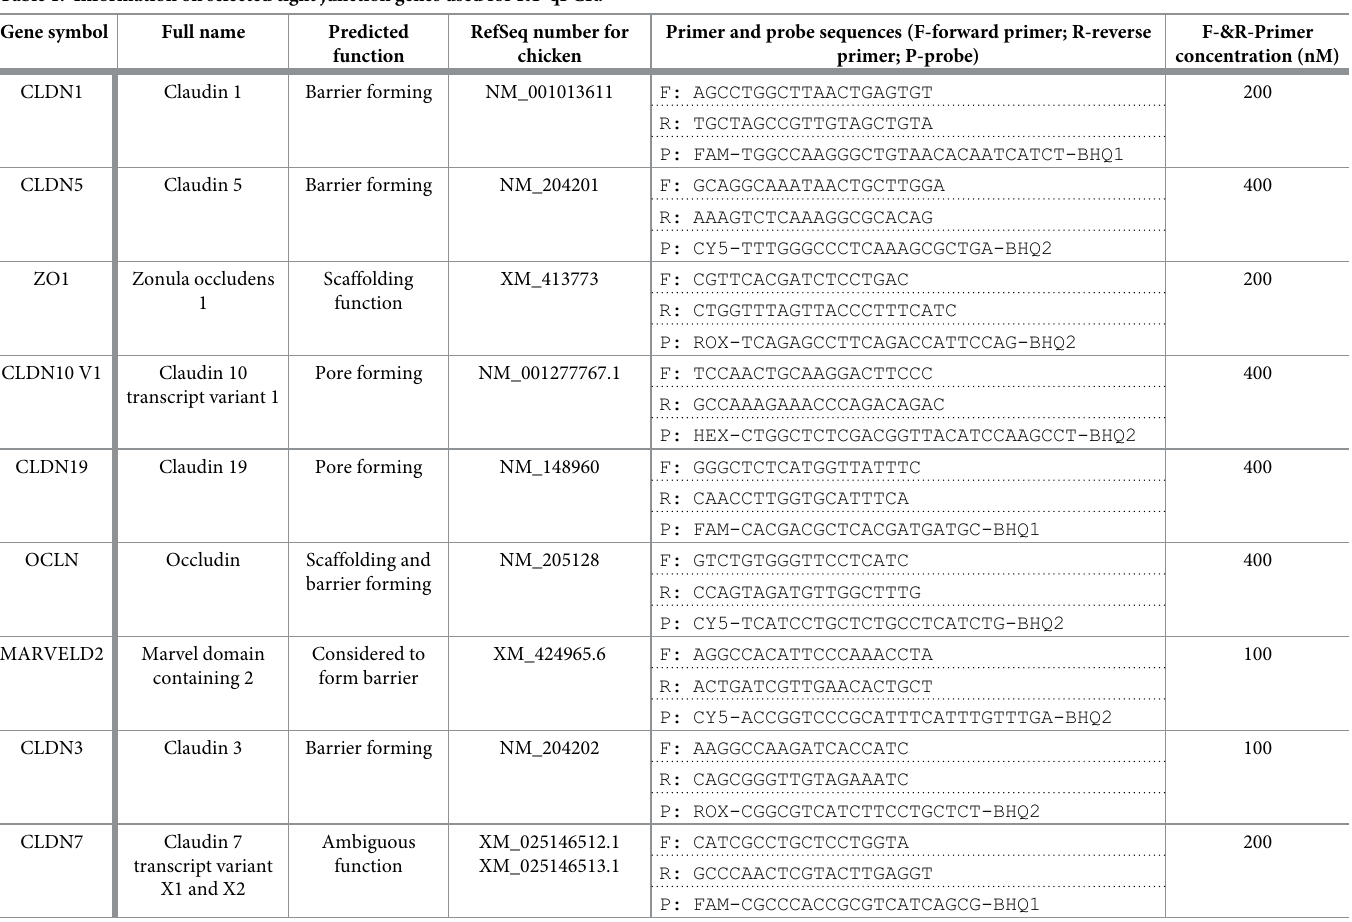
Table 1. Information on selected tight junction genes used for RT-qPCR. Gene